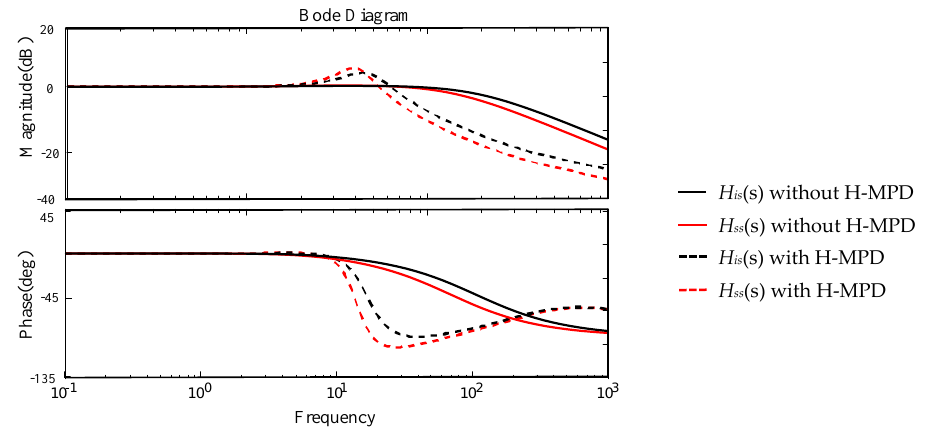
Figure 7. Phase margin of VSC when the proposed controller was used with different K .